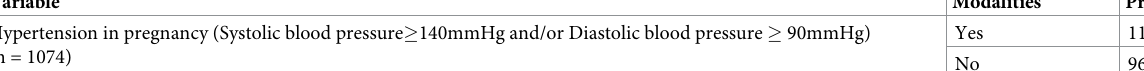
Table 1. Prevalence of some adverse maternal and foetal outcomes.